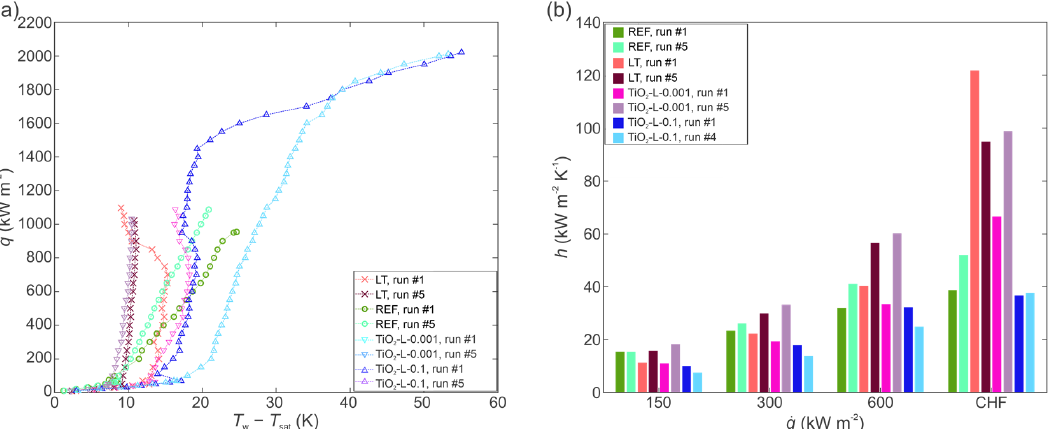
Figure 14. Comparison of boiling characteristics of TiO 2 -water nanofluids-small size NPs with base fluid on the reference and LT surface (1st and 5th run): boiling curves ( a ) and HTCs ( b ).